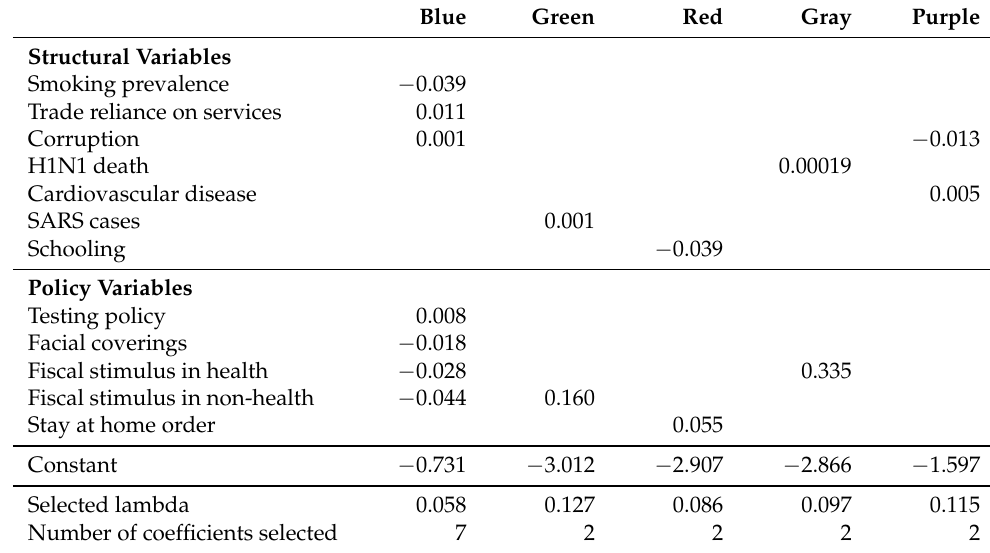
Table 4. Logistic LASSO regression